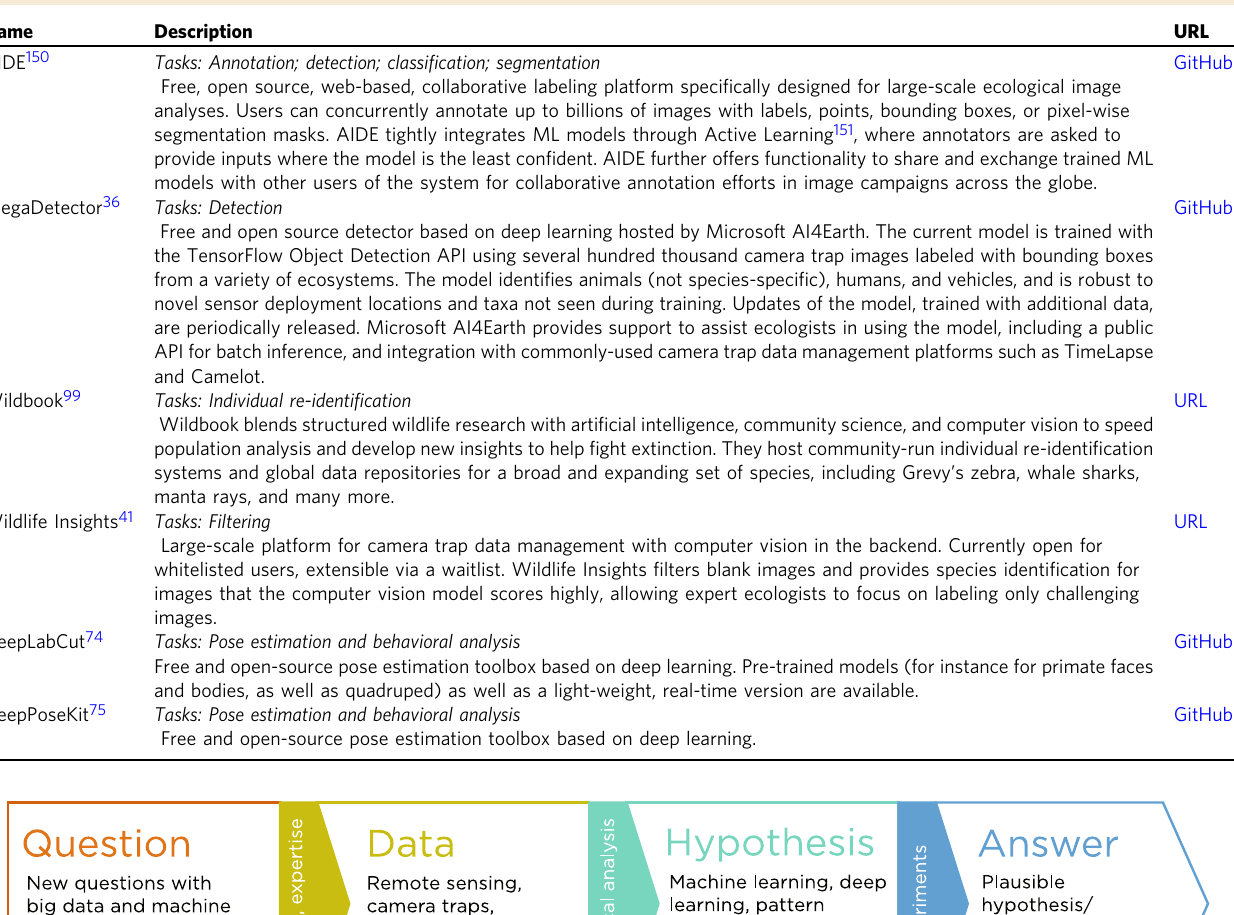
Table 1 Resources for machine and deep learning-based wildlife conservation.